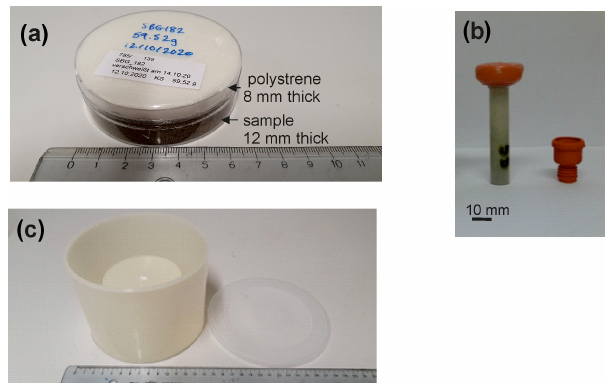
Figure B1. Sample holders typically used for measuring a gamma